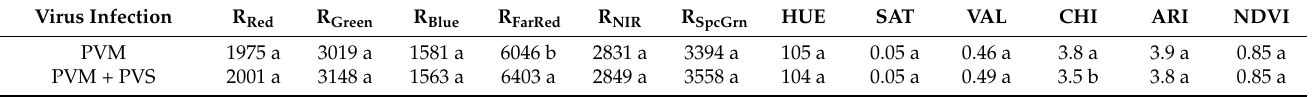
Table 6. Multispectral parameters as affected by the sanitary status of the